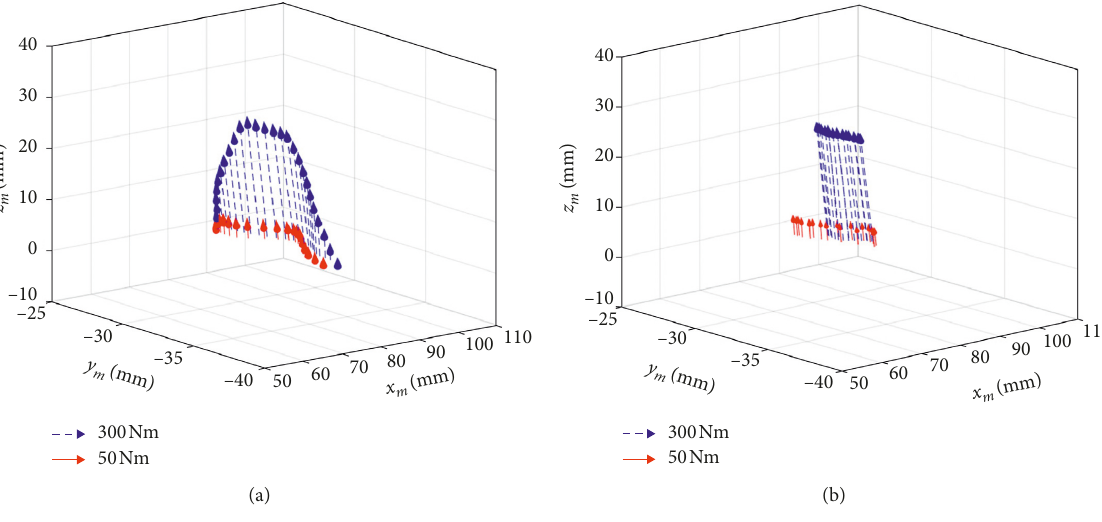
Figure 6: Mesh vectors of the MMTP (a) and the MMGP (b).